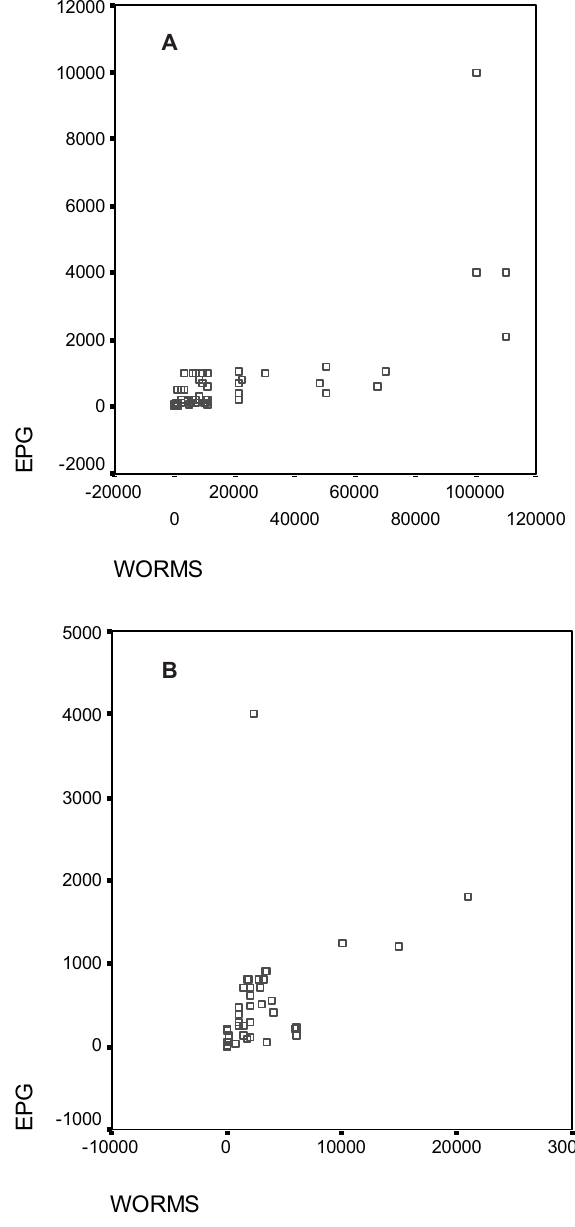
Fig. 1. – Relationship between egg per gramme and actual worm burden in young cattle (less than 12 months old: reinterpreted from Suarez, 1997-A) and sheep and goats (reinterpreted from Cabaret et al .,